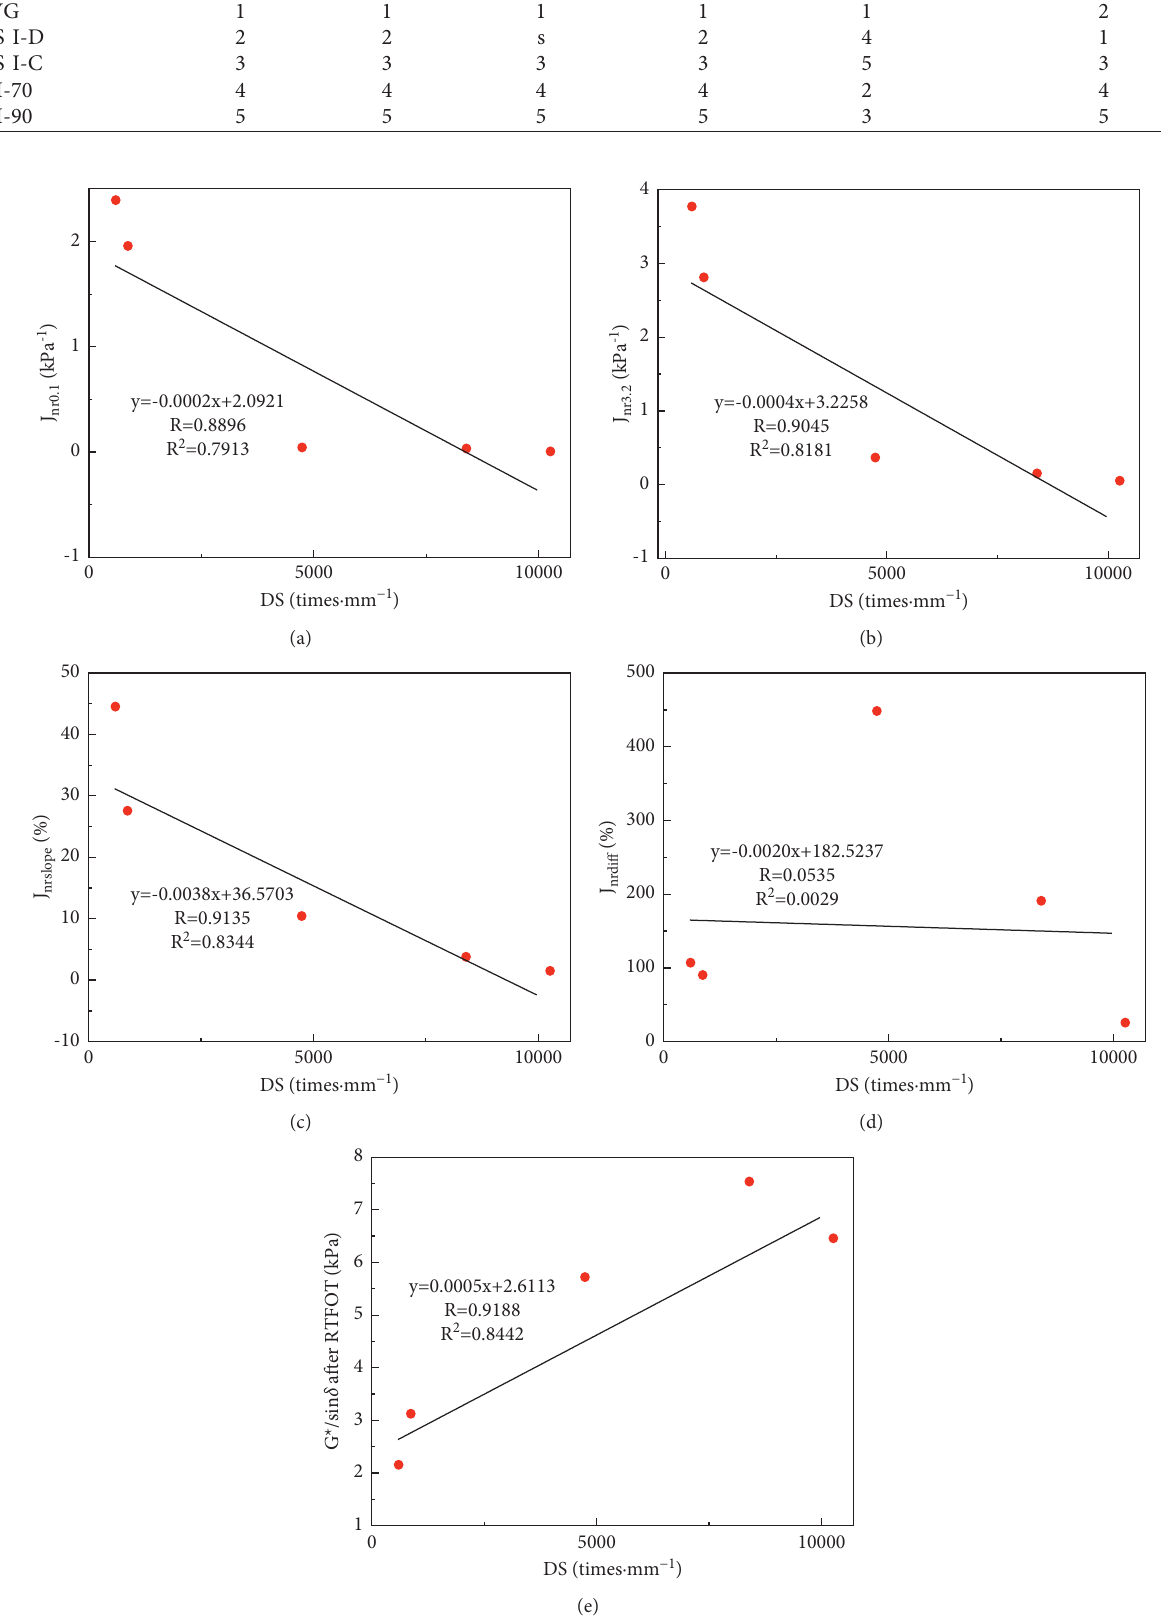
Figure 5: Correlations of DS and (a) J